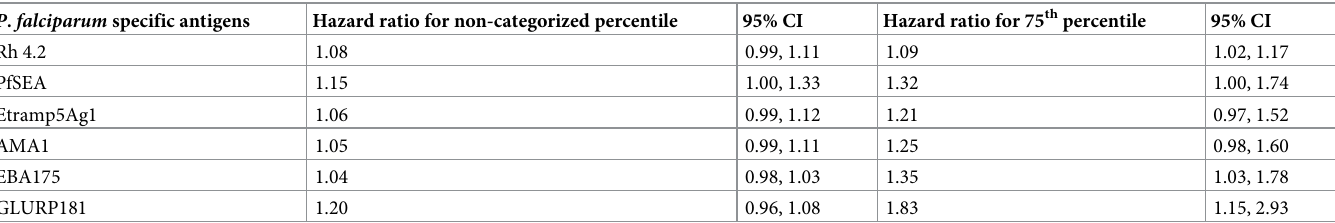
Table 3. Hazard ratios of non-categorized percentile compared to 75 th percentile of cord serum total IgG levels against selected P . falciparum antigen. P . falciparum specific antigens